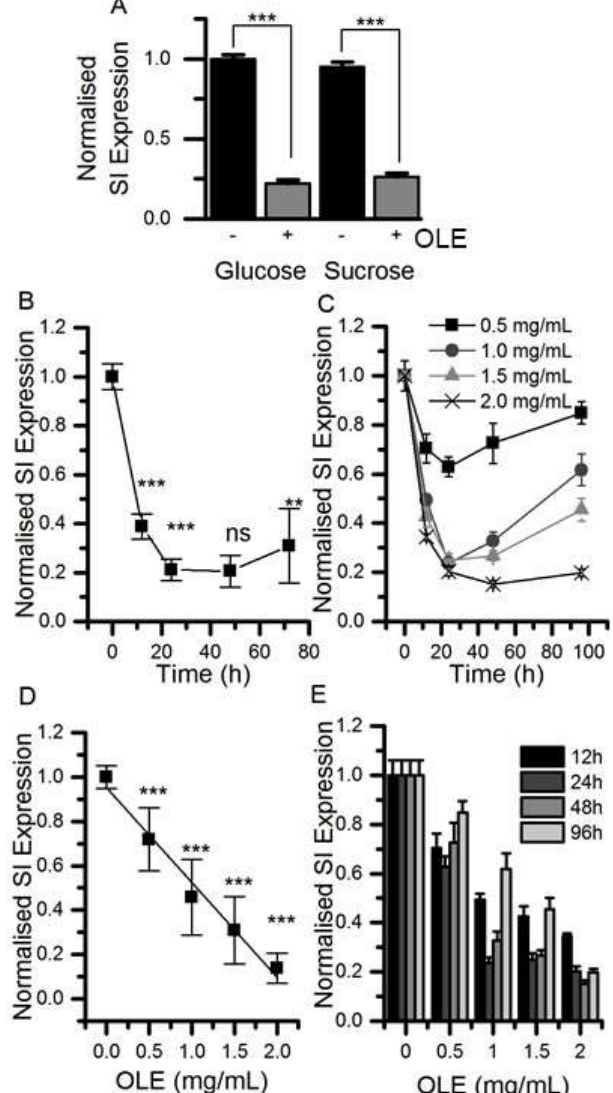
Figure 1. The effect of olive leaf extract (OLE) on sucrase-isomaltase (SI) mRNA expression. (Panel A ) Differentiated Caco-2/TC7 cells were cultured in 25 mM glucose or 25 mM sucrose for 21 days and treated with 1.5 mg/mL OLE for the final 3 days of differentiation. (Panel B ) shows the time course with 1.5 mg/mL OLE and (Panel C ) shows the concentration-dependence, both with n = 9, analysed in triplicate. Results are presented as normalised mean ± SD, p -values determined from ANOVA followed by Tukey’s post-hoc test, labels compare to previous point, *** p < 0.001, ** p < 0.01, ns = not significant. The time course was evaluated at four OLE concentrations ( D ) and the concentration response ( E ) was evaluated at four time points (3 replicates each). SI expression is normalised to for TBP (TATA-box binding protein) as detailed in the experimental section; + indicates with OLE, - indicates without.